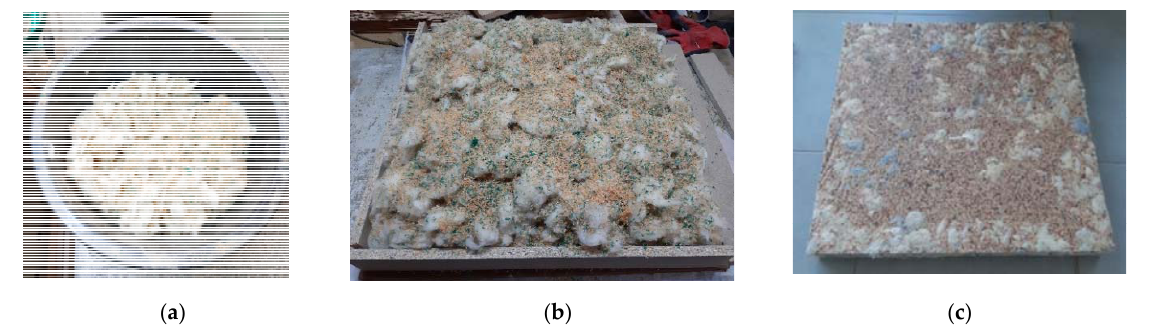
Figure 1. ABS-wool panel formation: ( a ) ABS (60%) and wool (40%) prepared to be mixed; ( b ) Mat formation in wooden frame; ( c ) Panel after sizing to the final dimensions.